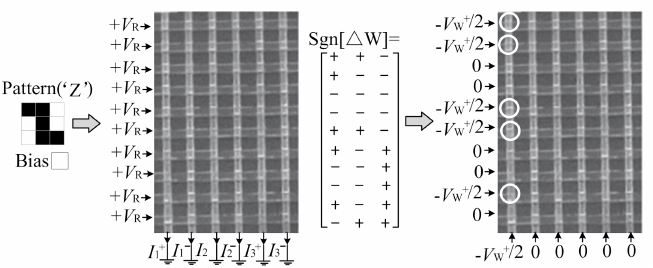
Figure 15. Single layer perceptron implemented using 10 × 6 memristor crossbar